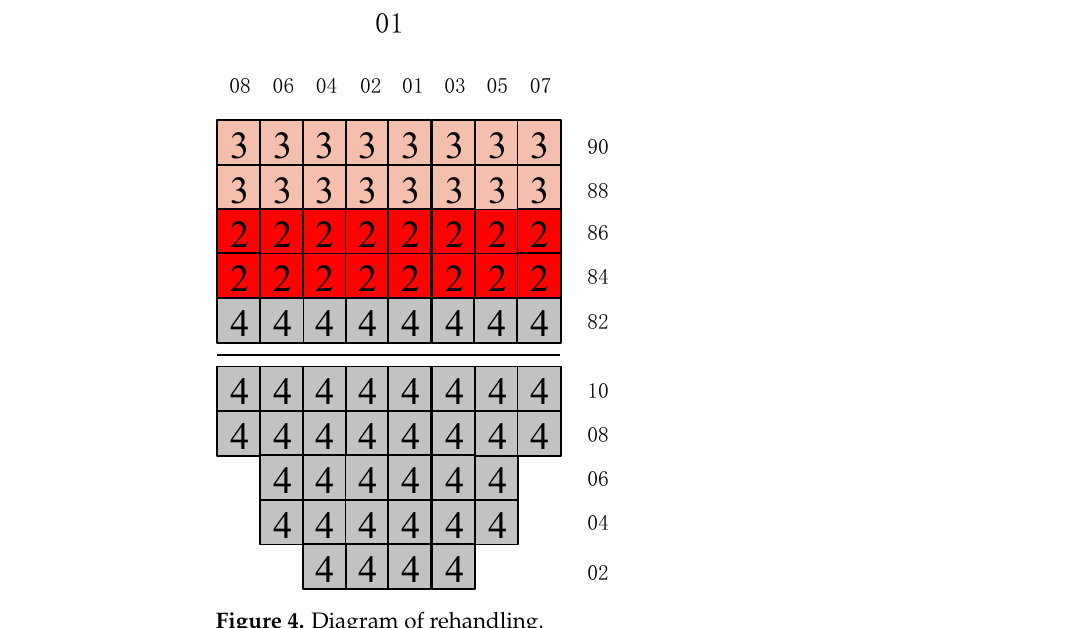
Figure 4. Diagram of